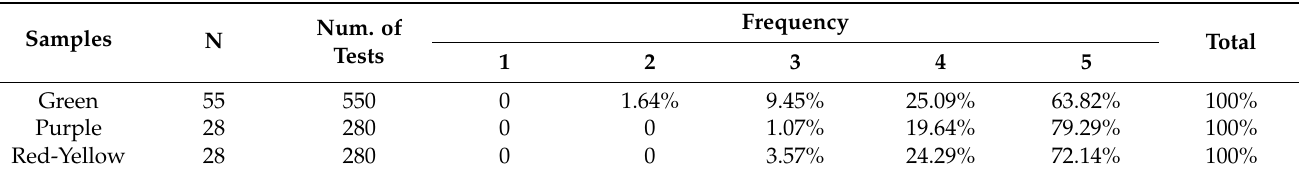
Table 1. Results of the expert group’s similarity